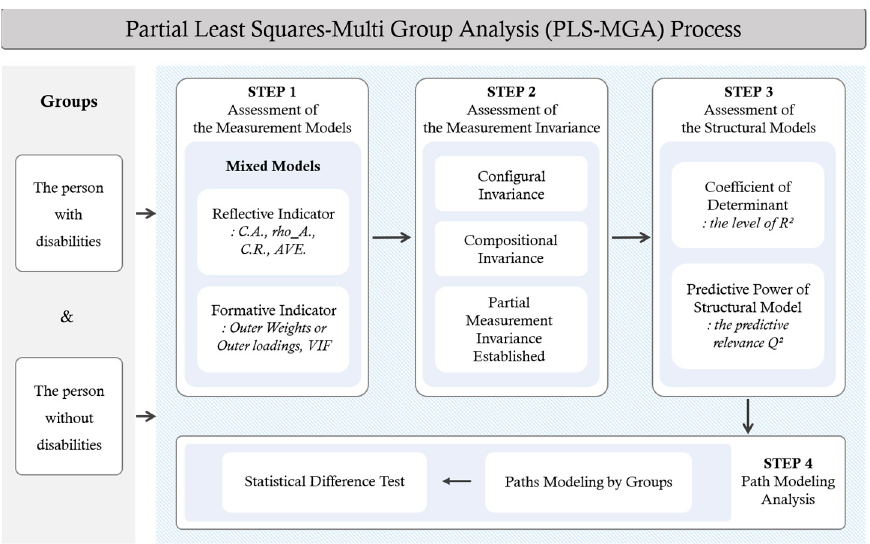
Figure 1. The Process of PLS-MGA